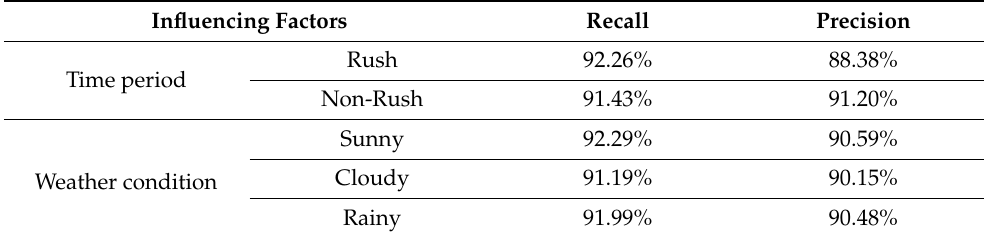
Table 3. The influence of external factors on the estimation accuracy.